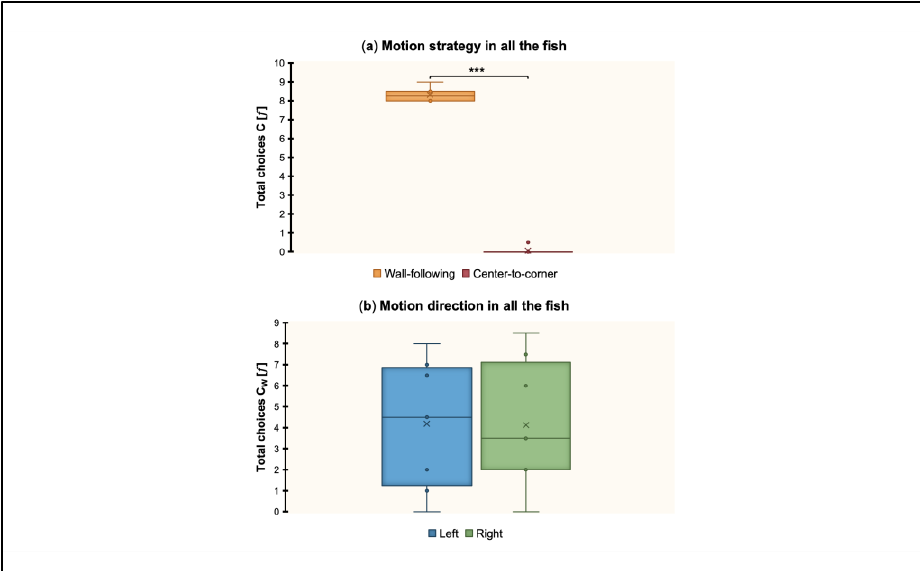
Figure 7. Motion patterns by collapsed conditions (PS, PL, DS, DL). ( a ) Motion strategy: wall-following vs. center-to-corner. ( b ) Motion direction: left vs. right. Mean ± SEM are shown. Significant p values are indicated with asterisks (*** p < 0.001).